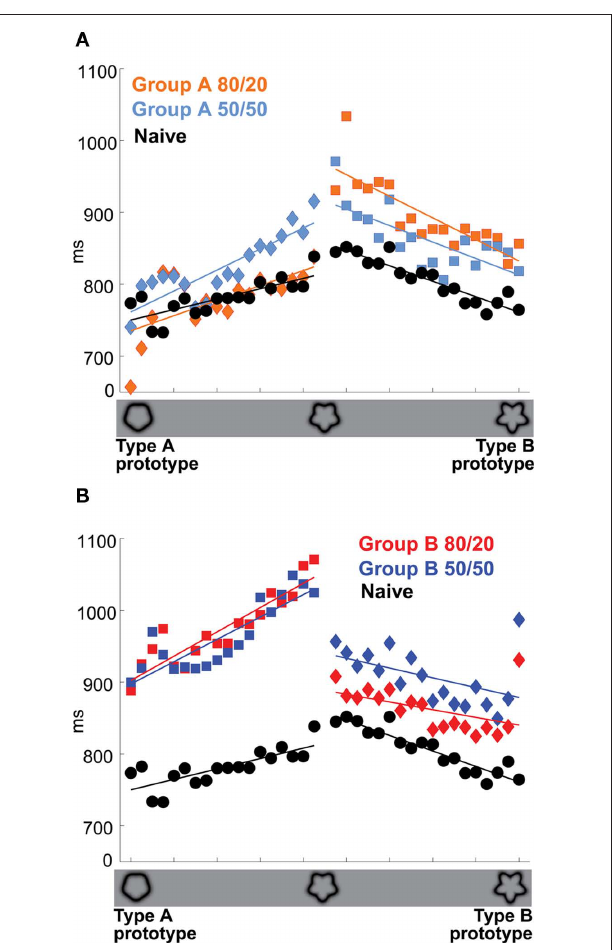
Figure 4 | Priors training slows response time at 50/50 relative to naive subjects. (A) Group A vs. naive subjects. Colors and x-axis are as in Figure 3. Diamonds: Targets indicated as likely in the 80/20 training. Circles: Targets presented to naive subjects. Responses to indicated targets were faster than responses to contraindicated targets, even when the cue was 50/50: p < 0.00001 at 80/20, p < 0.05 at 50/50. (B) Group B vs. naive subjects. Format as in (A) ; p < 0.00001 at 80/20, p < 0.01 at 50/50. All p -values were determined by paired t